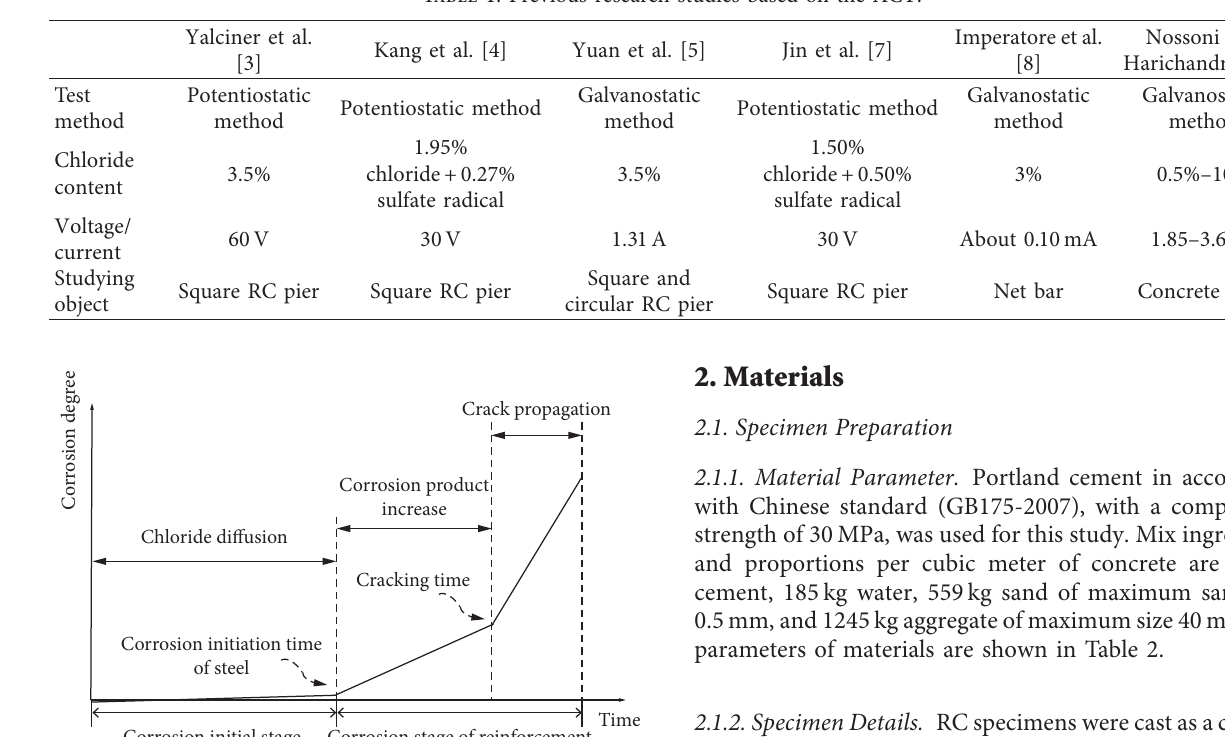
Table 1: Previous research studies based on the ACT.